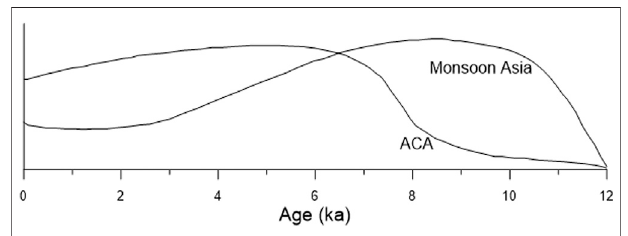
FIGURE 9 | The synthesized Holocene effective-moisture evolution in arid Central Asia (ACA) and monsoon Asia (Chen et al.,